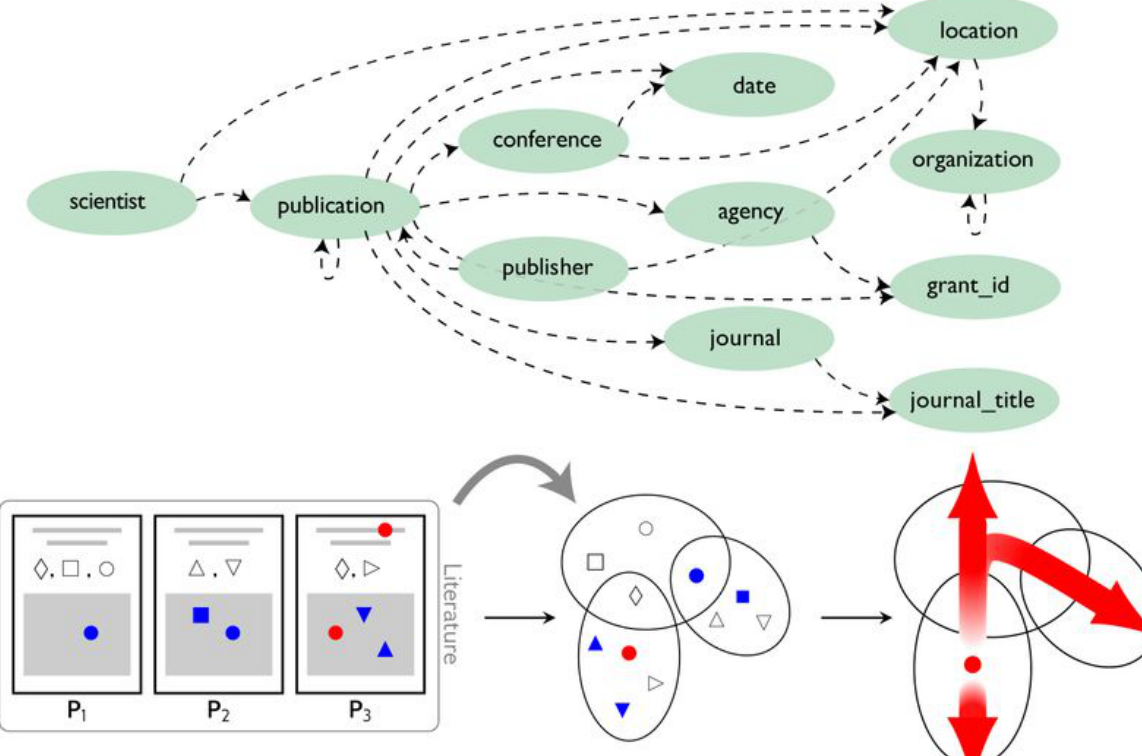
Figure 1. Connecting content and context. Top: Simplified Web of Science graph database schema. Self-edges imply that one record references another (e.g., in publications, articles and conference papers reference other articles and conferences; in organizations, some organizations like schools and departments live within others.) Bottom: Pipeline of papers through graph database to novel data structures like the mixed hypergraph illustrated, which facilitate simulations of random walk processes, or creating representations suitable for use within Graph Neural